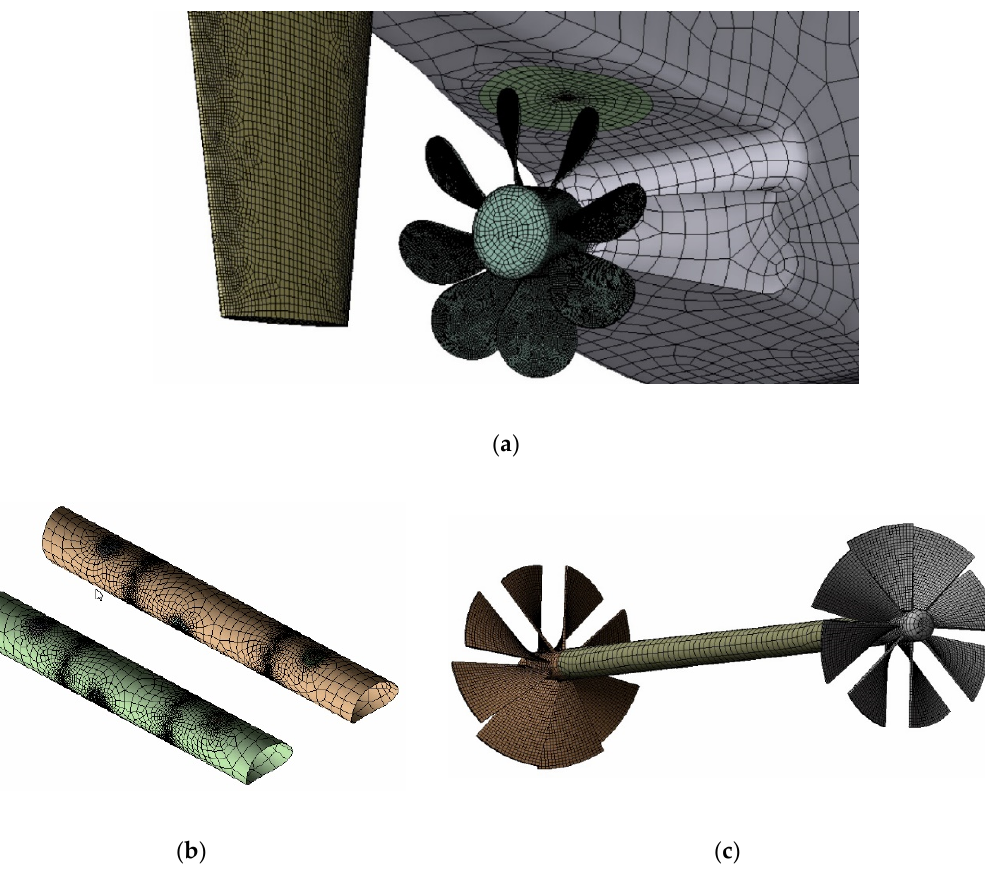
Figure 8. Details of boundary element discretization. ( a ) Stern region; ( b ) thruster tubes, ( c ) thruster propellers shaft.